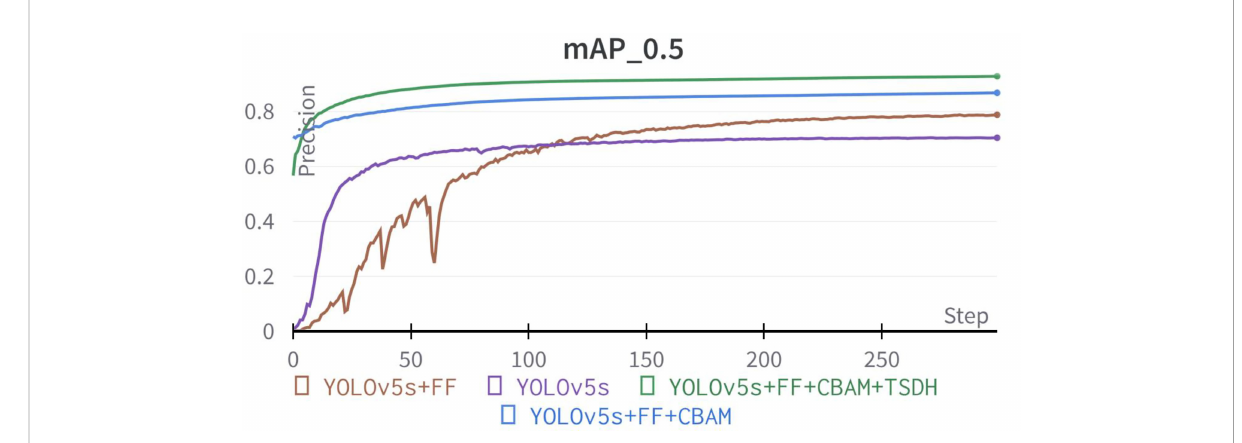
FIGURE 13 The mean average precision comparison of YOLOv5s prediction model based on different improvement strategies.